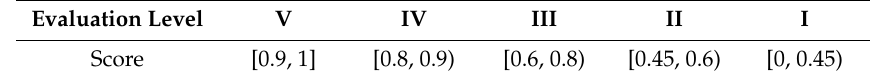
Table 6. Low-carbon sustainability and green operation benefits rating of power generation enterprises.